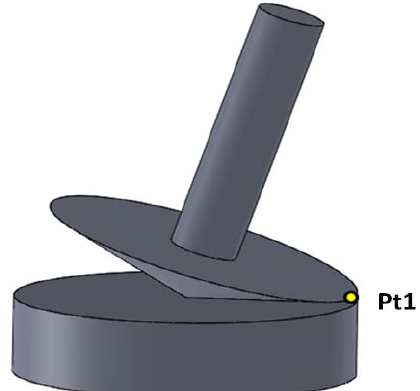
Figure 6: The geometrical setup of orbital motion analysis